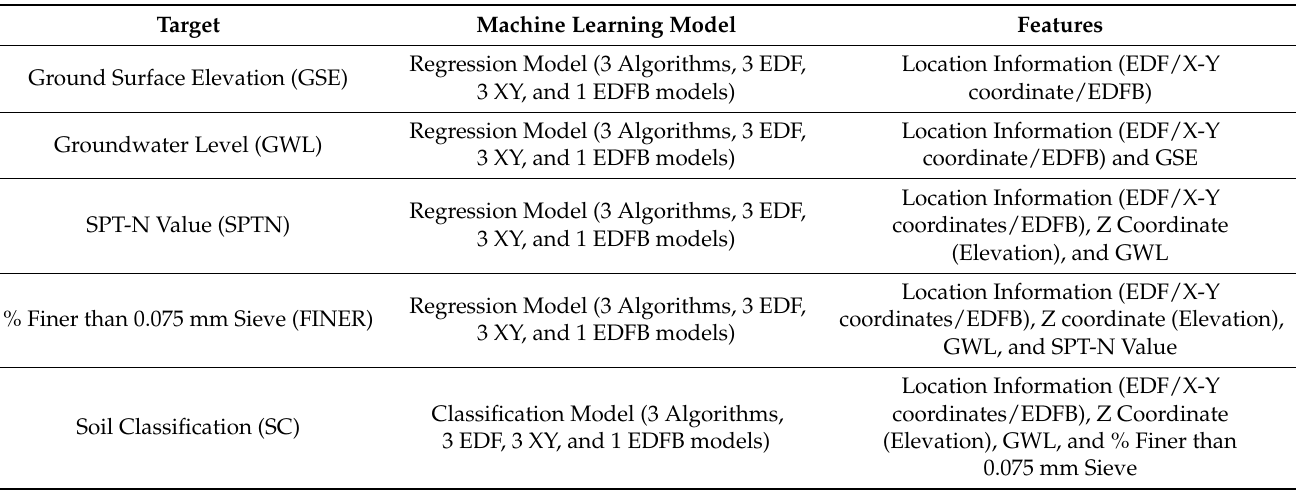
Table 3. Constructed machine learning models in this